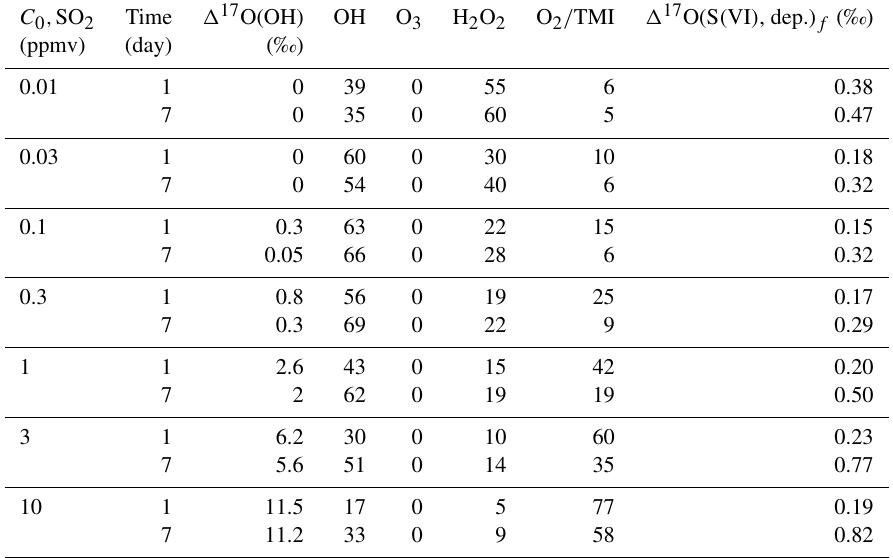
Table 6. Contribution to sulfate production from different pathways of sulfur oxidation at varying initial concentration of SO 2 . C 0 , SO 2 Time (cid:49) 17